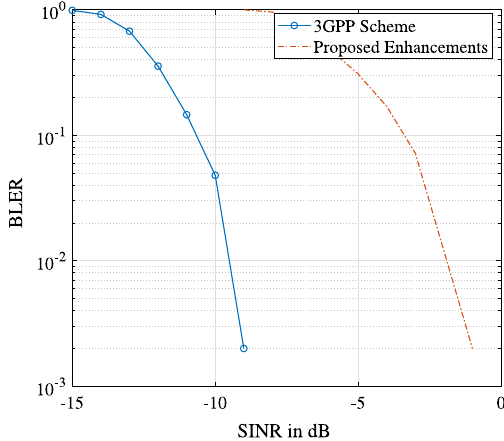
Fig. 16 VoIP evaluations used for calculating cell radius in Table